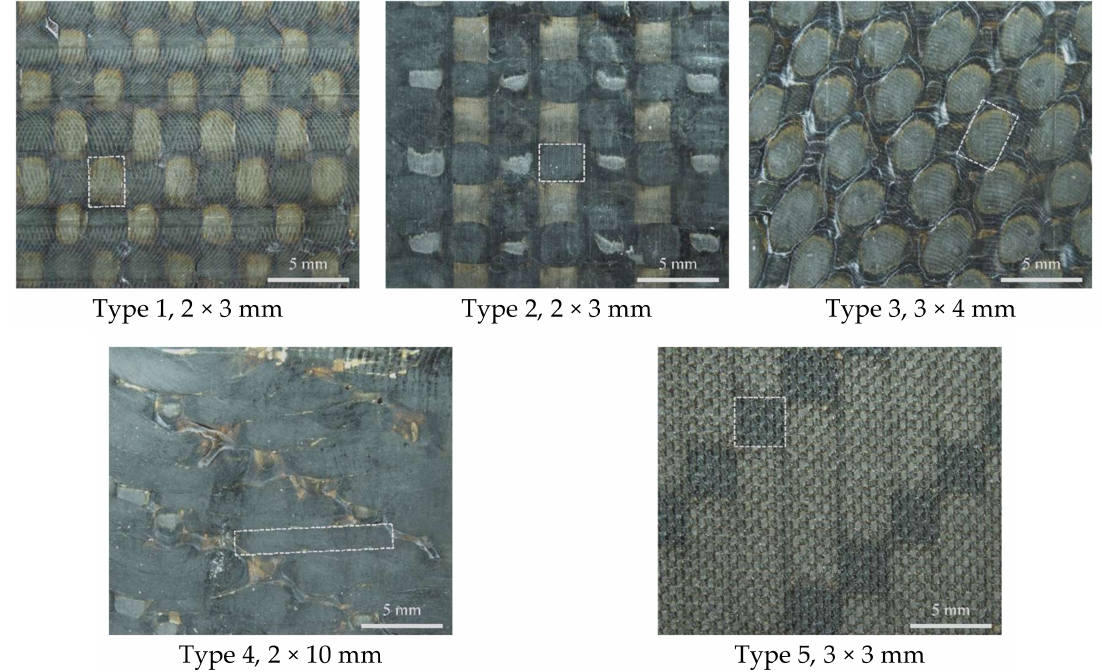
Figure 2. Photo of the surface of samples of three-dimensional-reinforced composites of various weaving patterns with a highlighted structural element ( δ